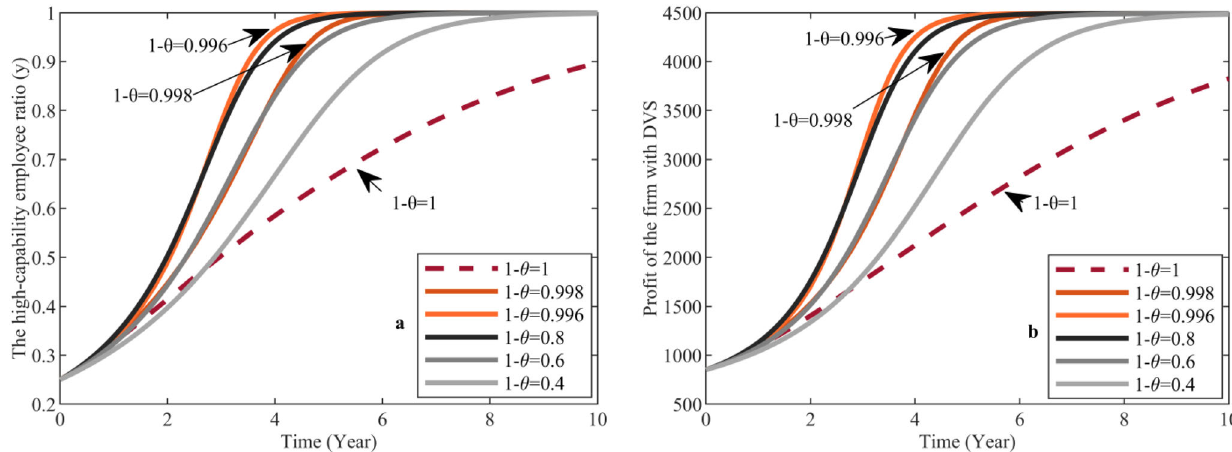
Fig. 10 The effect of the ratio of overall pro fi t sharing (1 − θ ) on the proportion of high-capability employees and the pro fi t of the fi rm. a Evolution of high-capability employees with different 1 − θ . b Evolution of pro fi t with different 1 − θ .